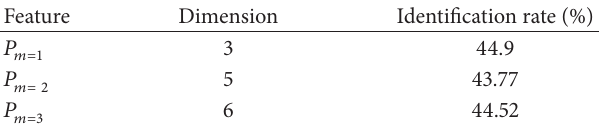
Table 1: Performance evaluation using approximated LFE contours.